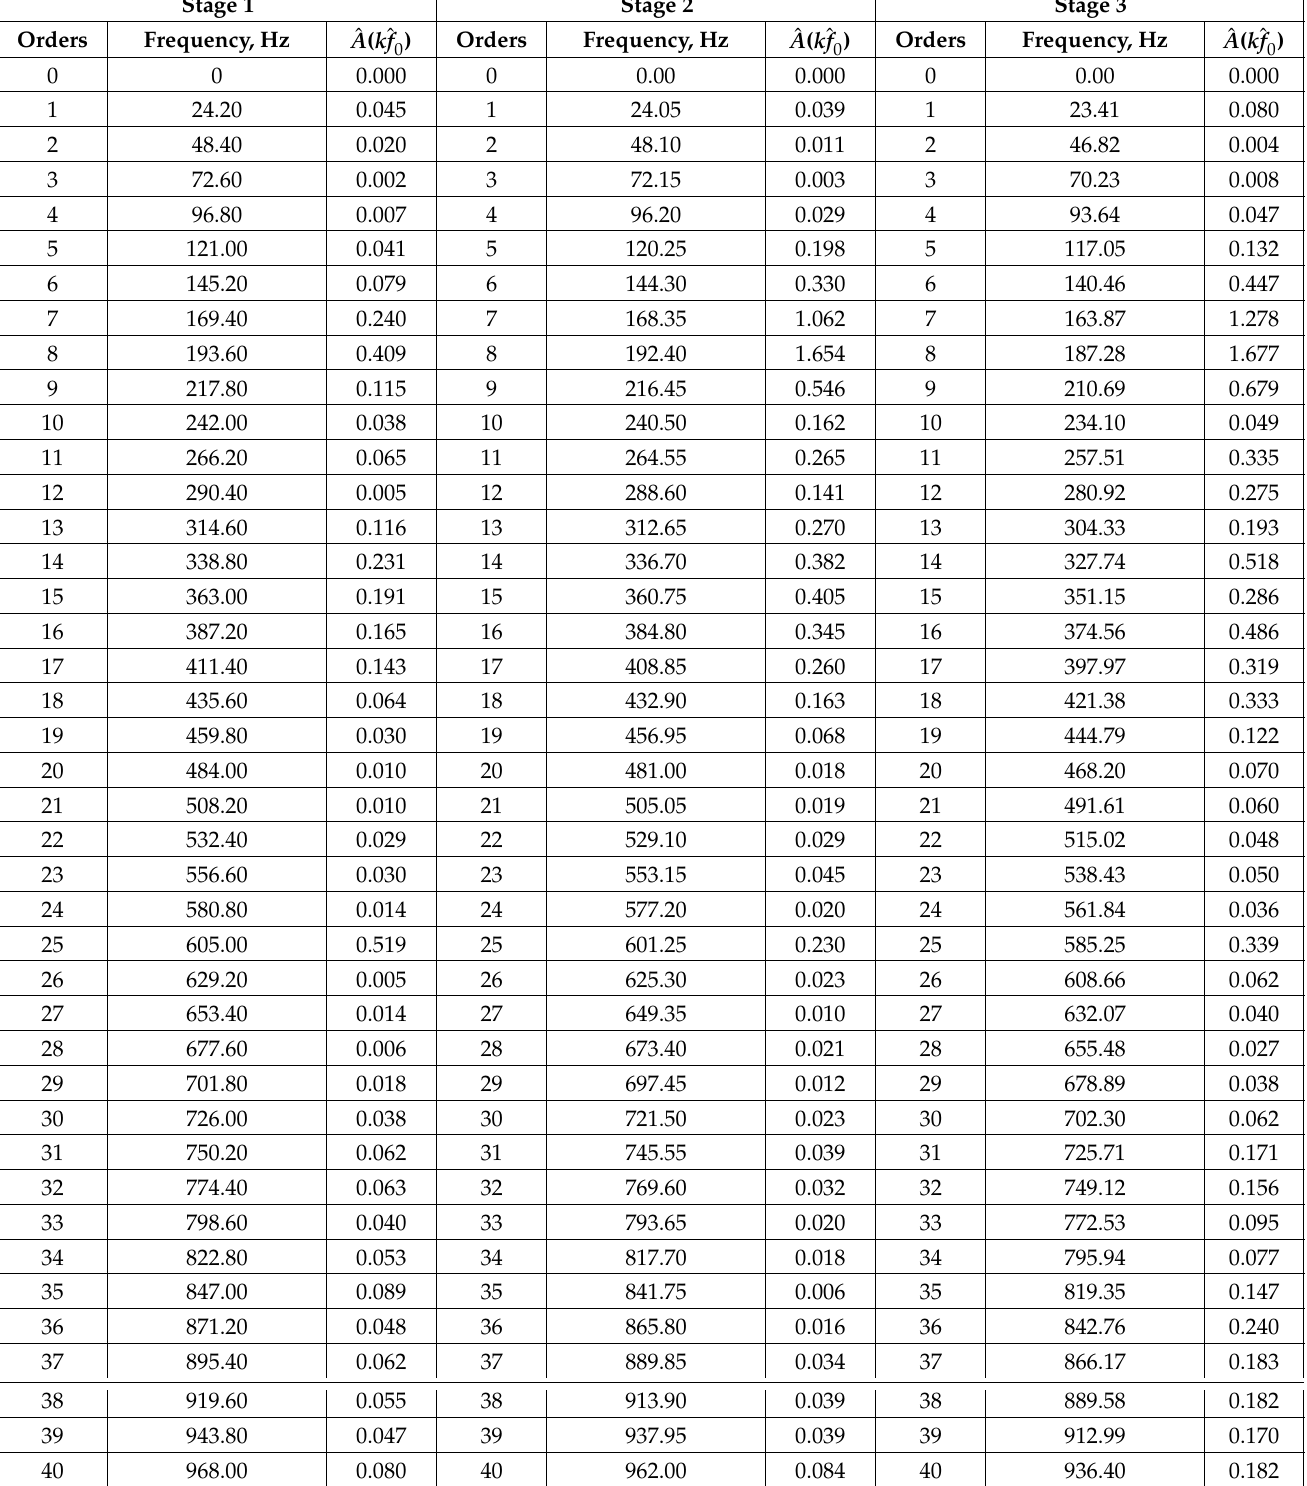
Table 1. Amplitudes of the deterministic oscillations